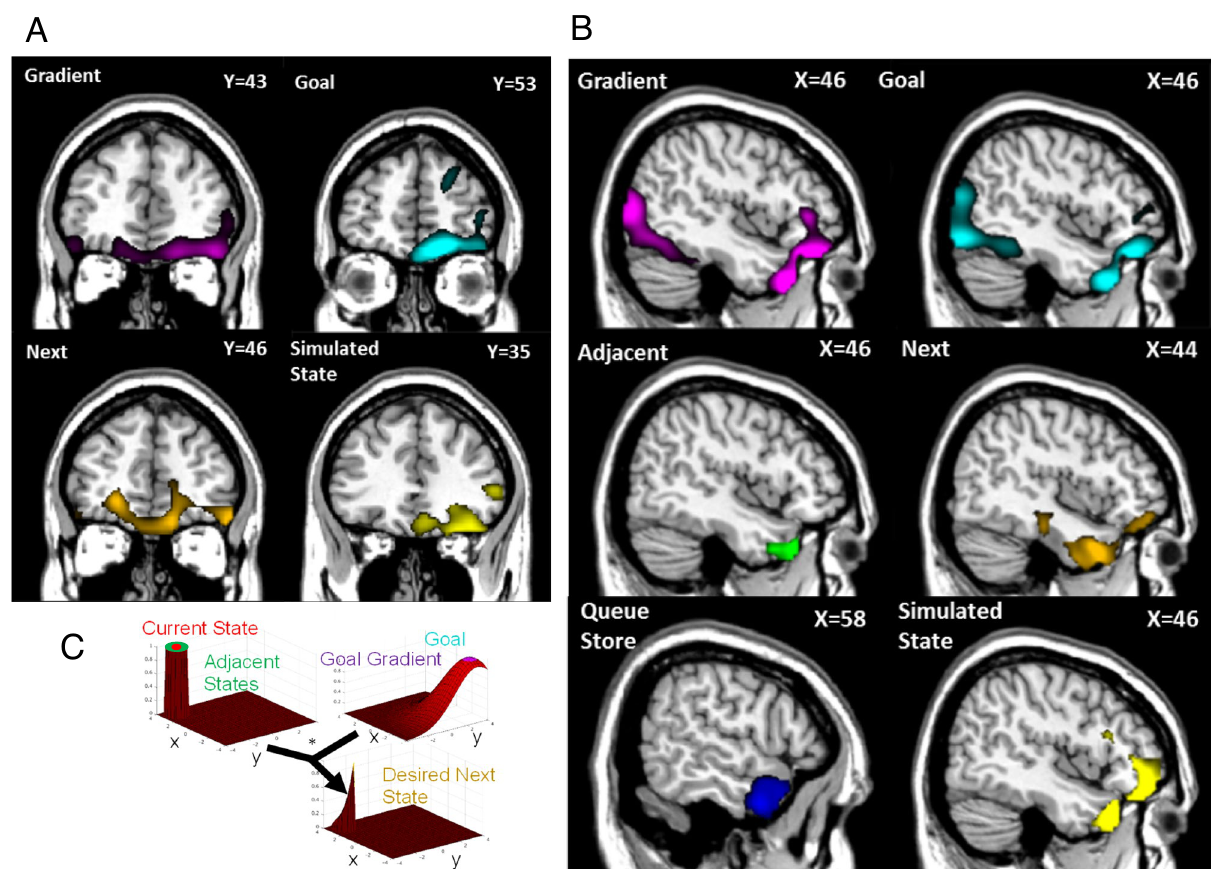
Figure 3. Representational Similarity Analysis (RSA) of model layers vs. human subjects performing the same Treasure Hunt task. All results shown are significant clusters across the population with a cluster defining threshold of p < 0.001 cluster corrected to p < 0.05 overall, and with additional smoothing of 8 mm FWHM applied prior to the population level t-test for visualization purposes. ( A ) population Z maps showing significant regions of similarity to model layers in orbitofrontal cortex. Cf. Figure 1 and Fig. 5B. The peak regions of similarity for goal-gradient and goal show considerable overlap in right OFC. The region of peak similarity for simulated-state is more posterior. To most clearly show peaks of model-image correspondence, the maps of gradient and goal are here visualized at p < 0.00001 while all others are visualized at p < 0.001. ( B ) Z maps showing significant regions of similarity to model layers in right temporal cortex. The peak regions of similarity for goal-gradient and goal overlap and extend into the OFC. The peak regions of similarity for adjacent-states, next-desired-state, and -simulated-state occur in similar but not completely overlapping regions, while the cluster for queue-store is more lateral. ( C ) Fig. 1A, copied here as a legend, where the font color of each layer name corresponds to the region colors in panels ( A) and ( B)